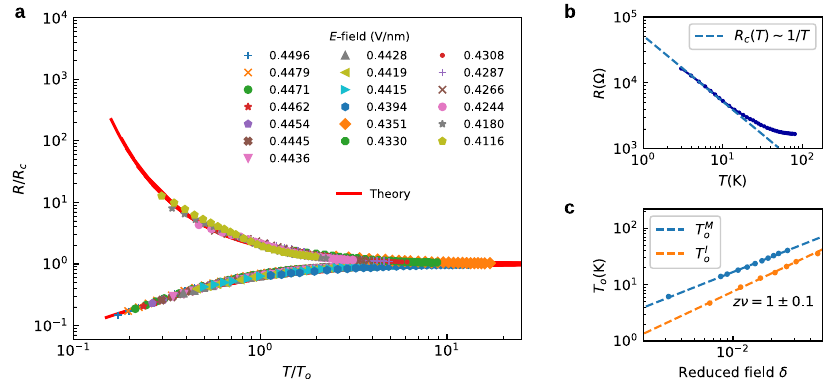
prediction for exponent x =1 (Supplementary Fig. 9). c Crossover temperature T o ( δ ) obtained from the scaling collapse of experimental data (the superscripts M and I designate respectively the metallic and insulating branch. The estimated critical exponent z ν ≈ 1±0.1 is consistent with the theoretical value z ν =1.